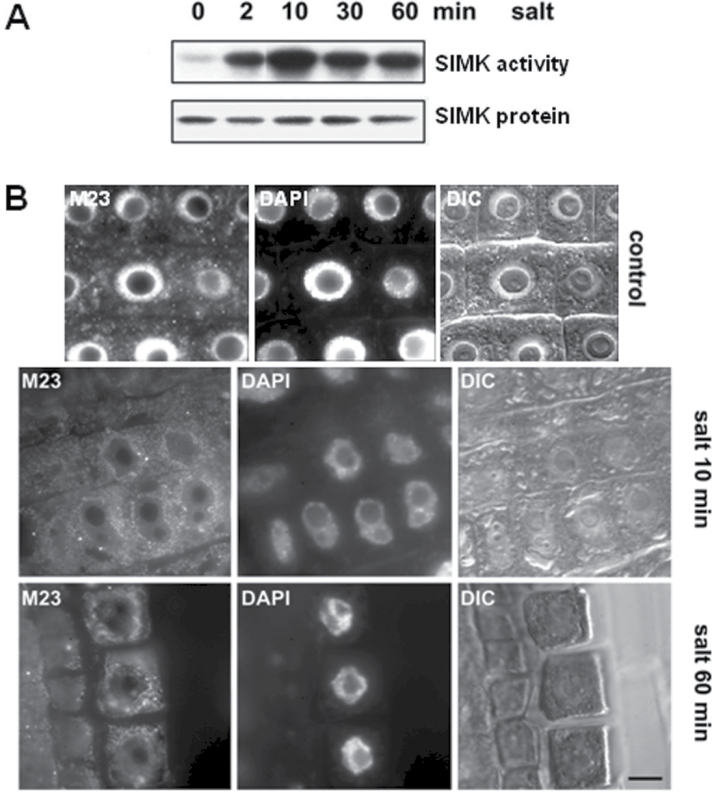
Salt-dependent activation and localization of SIMK in M. sativa roots. (A) Immunokinase analysis of time-dependent, persistent salt-induced activation of SIMK in intact M. sativa roots. Upper panel: M. sativa roots treated with 250mM NaCl for the indicated times. Root cell extracts were immunoprecipitated with protein A-purified SIMK-specific antibody M23. Kinase reactions were performed using MBP as a substrate. Lower panel: the same crude extracts from salt-treated roots were subjected to immunoblotting with the M23 antibody in order to check SIMK protein levels. (B) Immunolocalization of SIMK with M23 antibody in control and salt-treated (250mM NaCl) non-dividing cells of intact M. sativa roots. SIMK was abundant in the nuclei of control cells, whilst it relocated to punctate cytoplasmic compartments in salt-treated root cells. With increasing time (60min) of salt treatment, these cytoplasmic structures coalesced into larger patches that accumulated around the nuclei. Note the change in shape of the nuclei due to NaCl-induced plasmolysis. Images in the middle panel show nuclear DAPI staining. DIC, differential interference contrast. Bar, 5 μm (B).